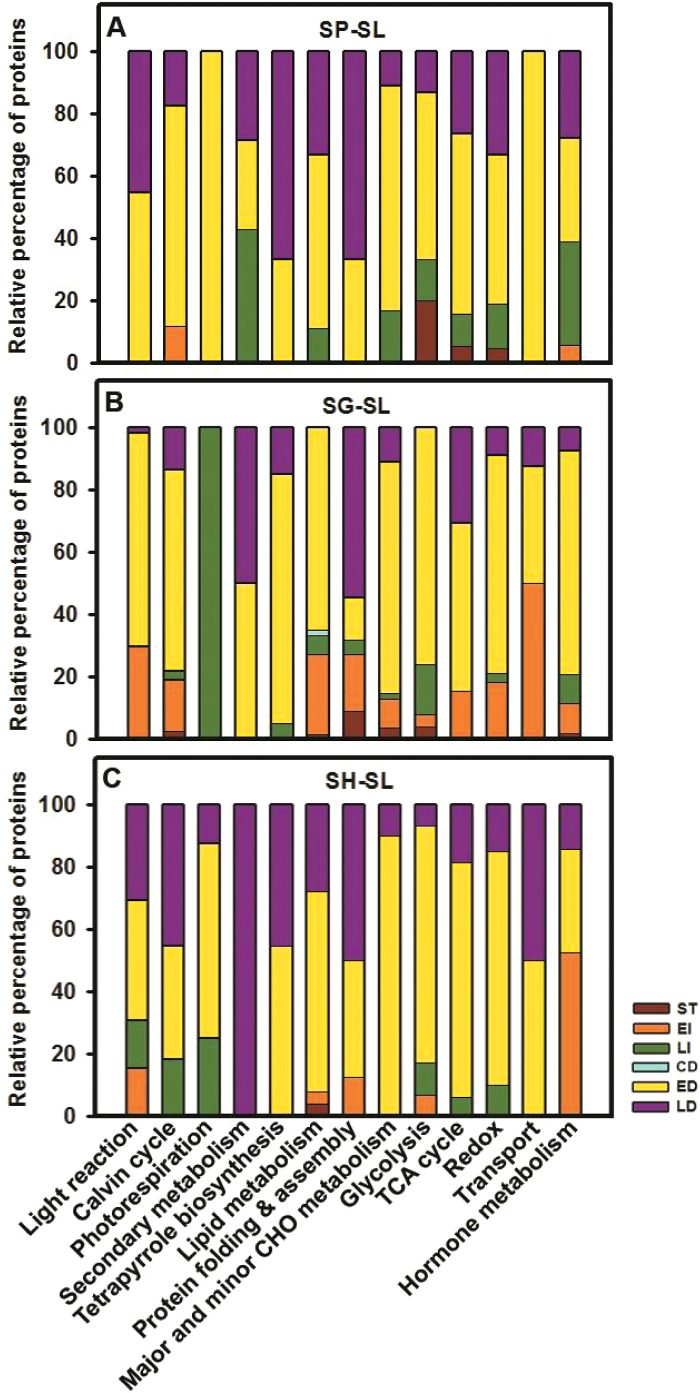
Abundance patterns of proteins involved in chromoplast formation. Proteins belonging to the functional classes with a presumed role in chromoplast formation from SP–SL (A), SG–SL (B) and SH–SL (C) were differentiated based on their abundance pattern as stable (ST), continuous increase (CI), early increase (EI), late increase (LI), continuous decrease (CD), early decrease (ED), and late decrease (LD), and presented in Table S6. The individual bars represent different protein functional categories. The relative percentage of proteins exhibiting the above abundance patterns is represented in the respective bars. (This figure is available in color at JXB online.)